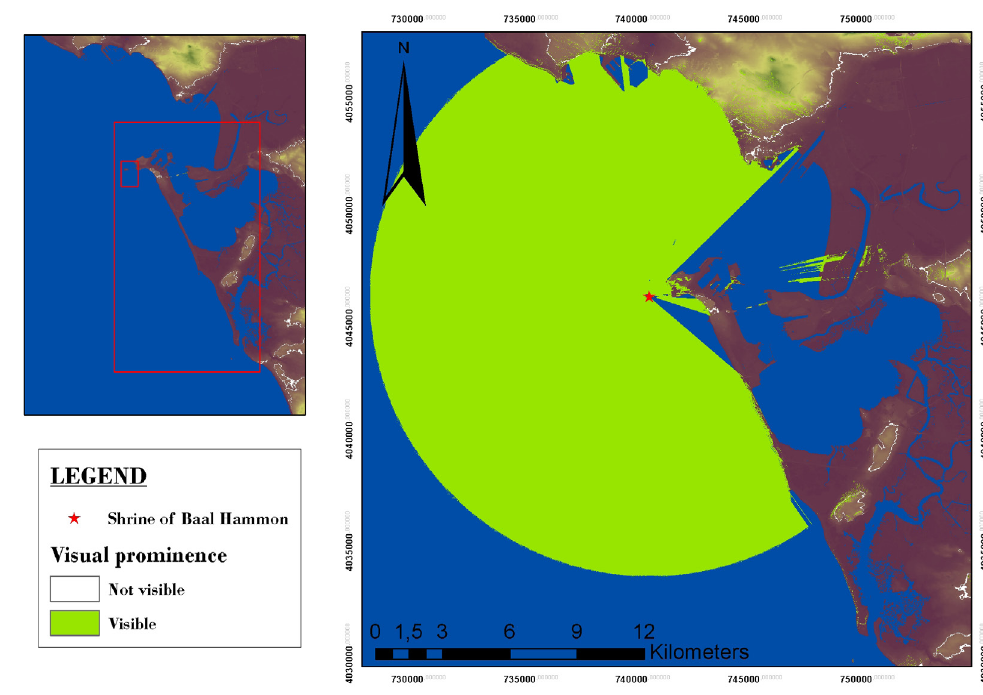
Figure 4. Theoretical or potential viewshed of the presumed shrine of Baal Hammon /San Sebastian Castle (right). Expansion of the same to beyond the islet of Sancti Petri and part of the continental interior (left). ©Authors.